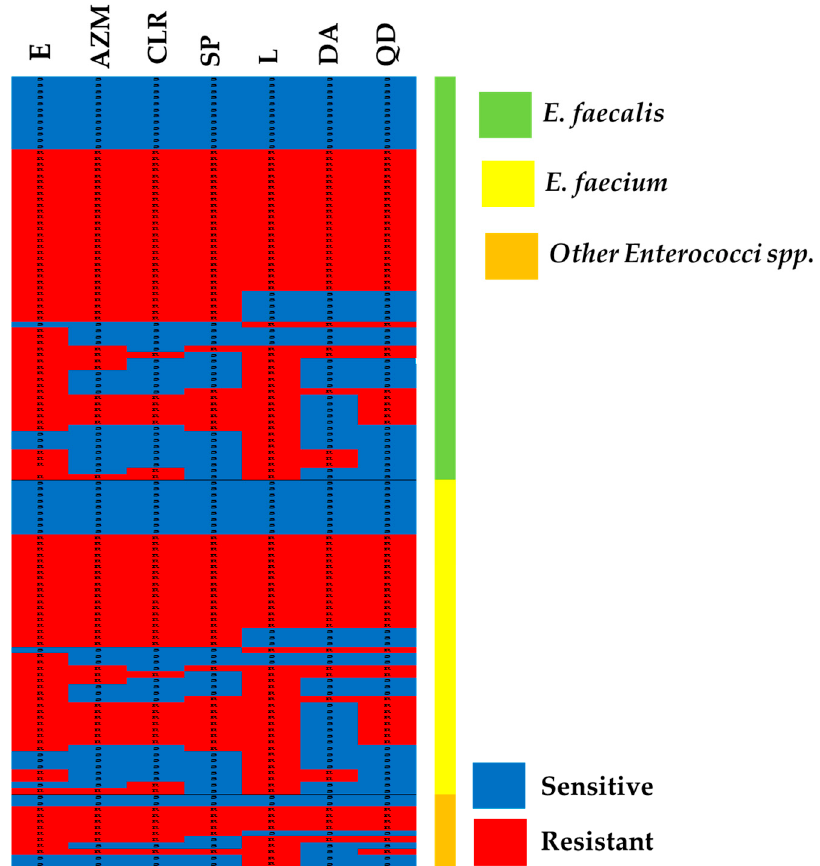
Figure 3. The resistance patterns to the tested MLS antibiotics. The heat map represents the resistance, where red represents the resistant isolates, and blue represents the sensitive isolates. The highest resistance was observed to erythromycin and lincomycin in both E. faecalis and E. faecium. E = Erythromycin, AZM = Azithromycin, CLR = Clarithromycin, SP = Spiramycin, L = Lincomycin, DA = Clindamycin, and QD = Quinupristin/Dalfopristin.